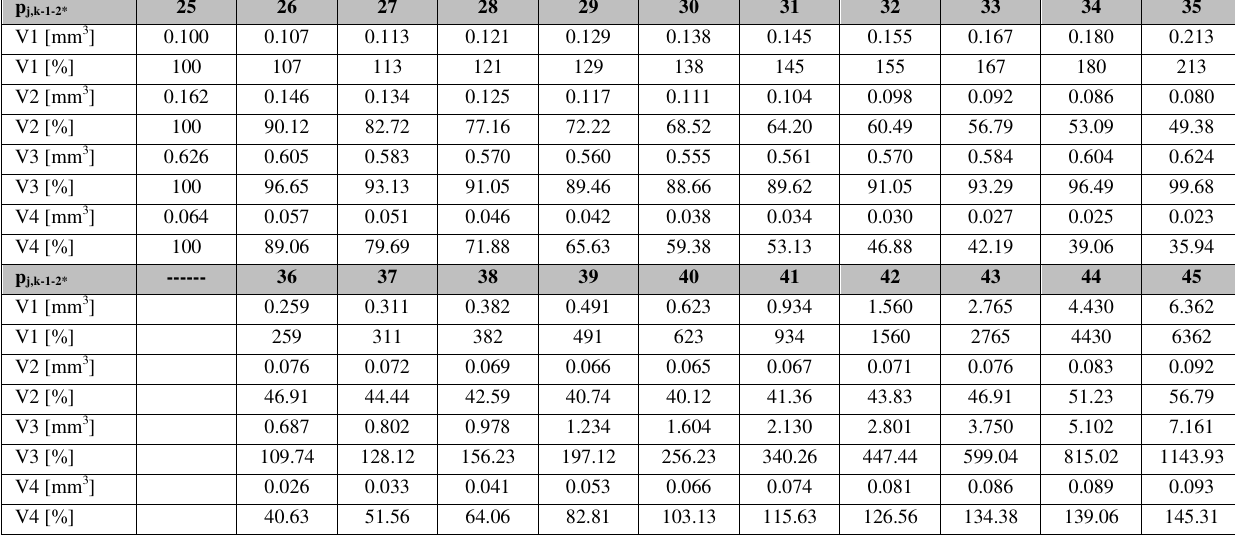
Table 1. Values of the coefficients determining the change in parameter p j,k-1-2 expressing the asymmetric shape of the sealing rings sliding surfaces on the volume of scraped oil in the individual engine running strokes into the crankcase in strokes V1 and V3, and into the combustion chamber in